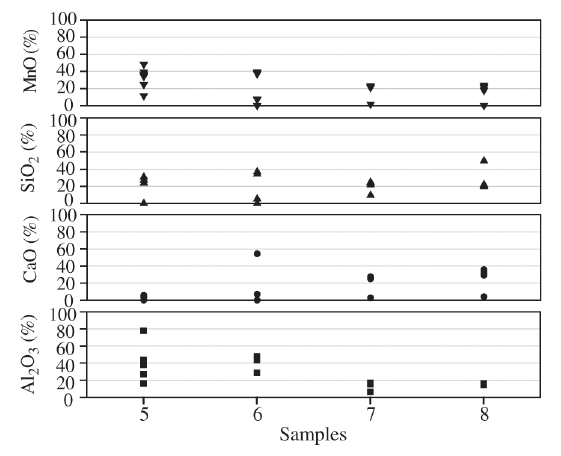
Figure 1. Evolution of the chemical composition of the inclusions in the samples of aluminum killed SAE 1010 steel.